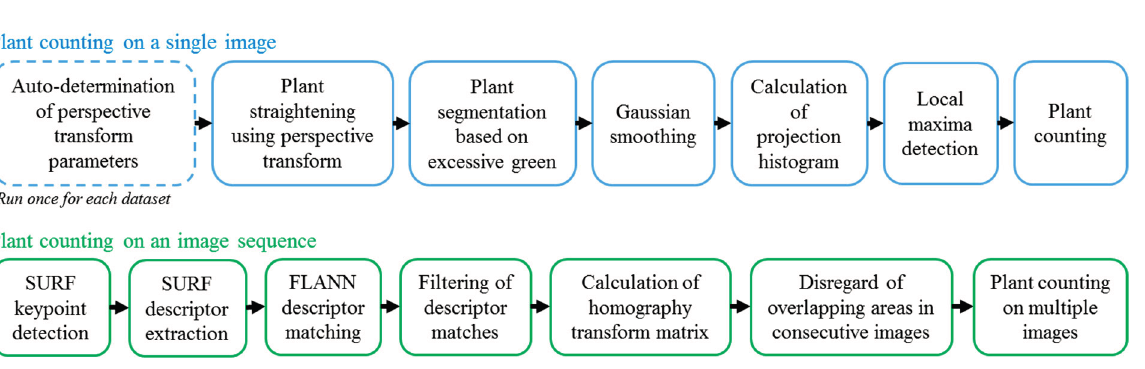
Figure 3. Flowchart representation of the